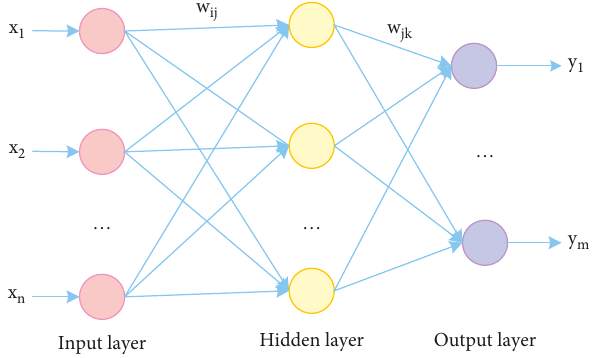
Figure 5: Schematic diagram of BP neural network structure.